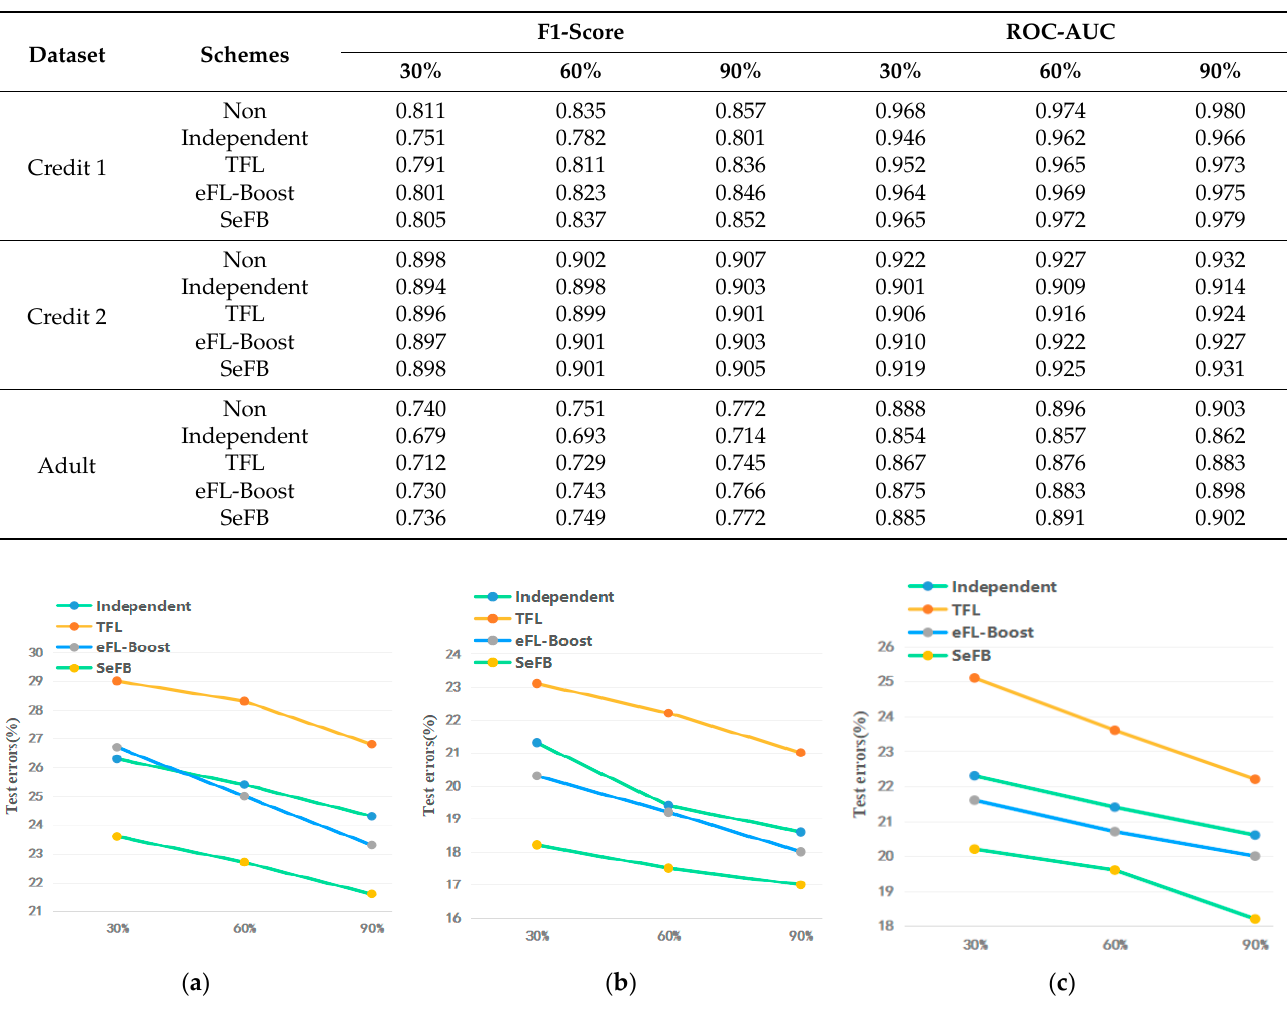
Table 8. Performance impact of data volume size.